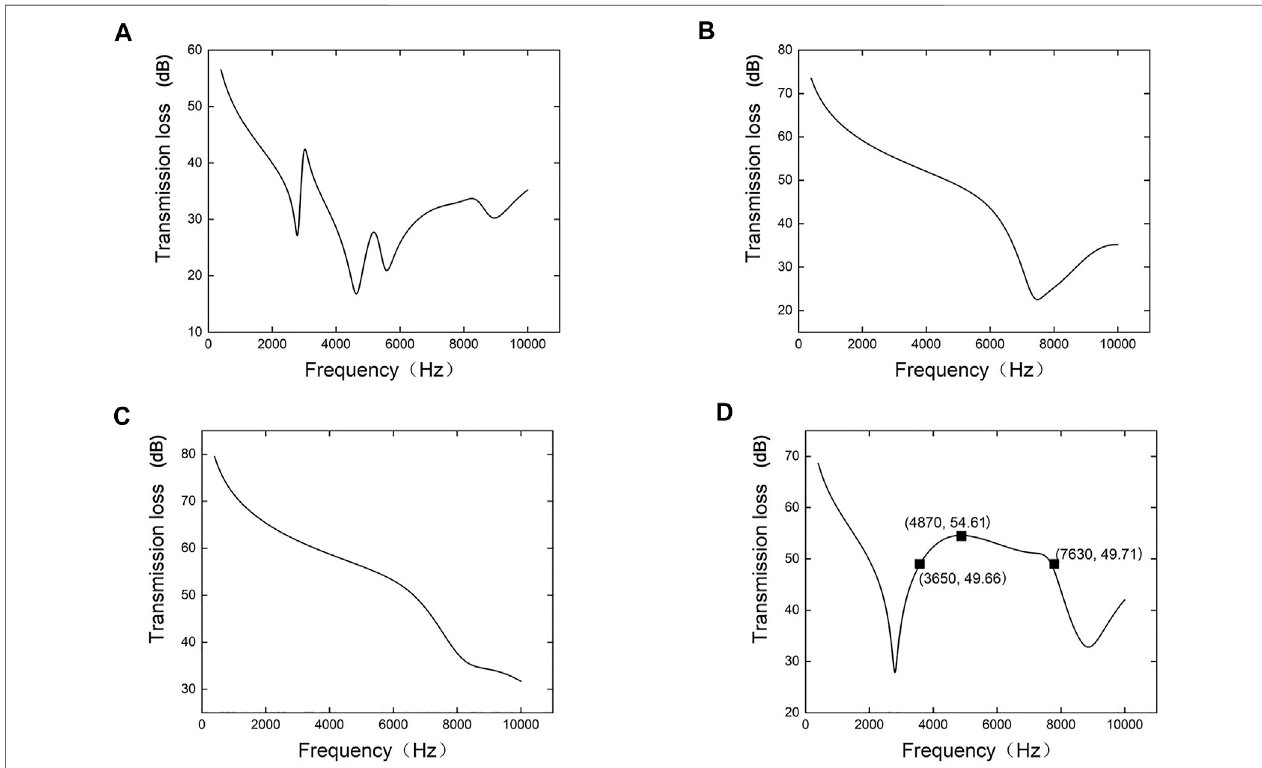
FIGURE 5 | Young ’ s modulus of three fi lms are: (A) all 2 MPa, (B) all 16 MPa, (C) 32 MPa, (D) in sequence 2 MPa, 16 and 32 MPa.